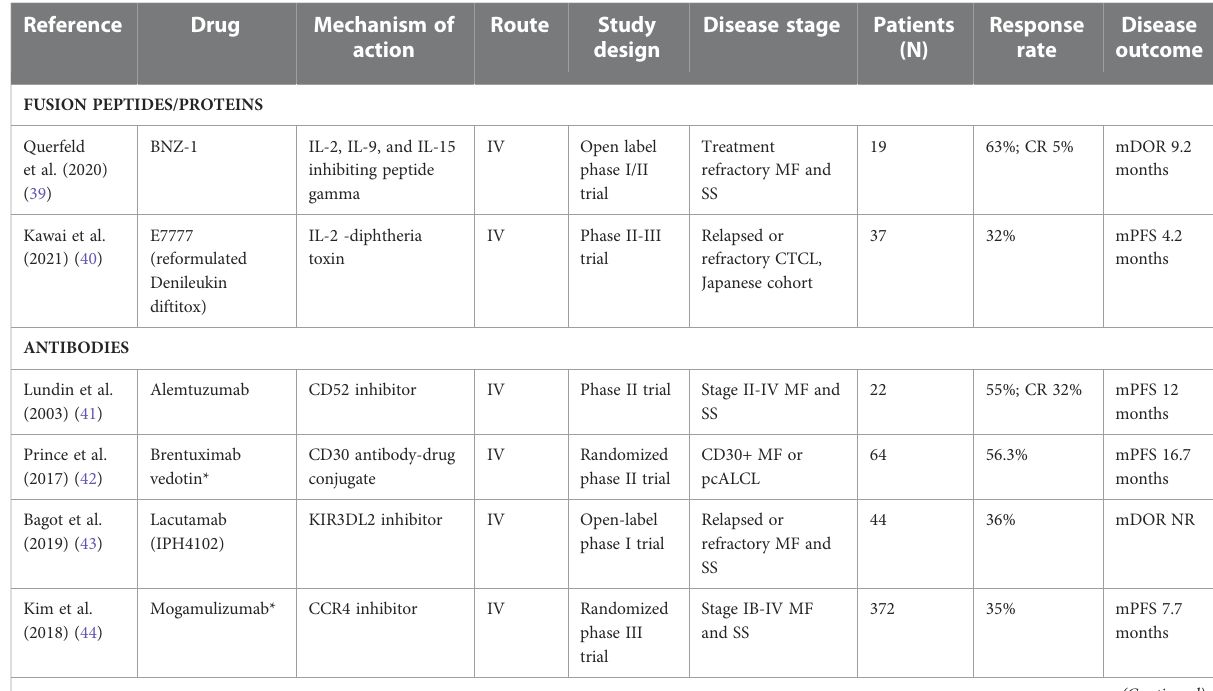
TABLE 4 Targeted therapies for the treatment of